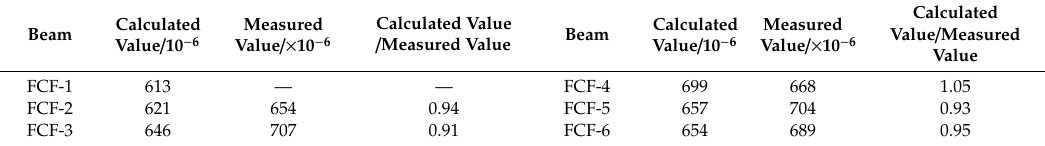
Table 4. Comparison of calculated values and measured values of strain increment.